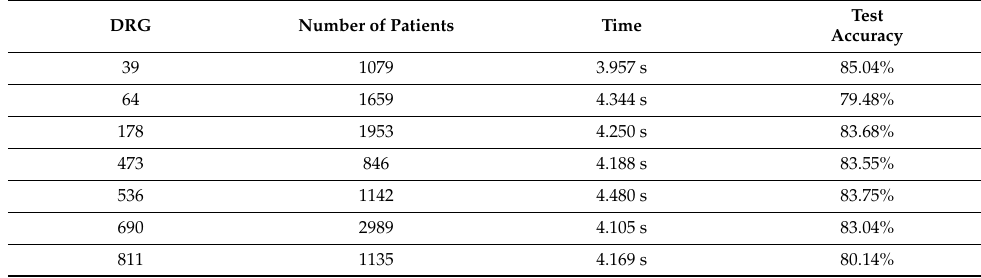
Table 1. Sequential Neural Network results on DRG billing